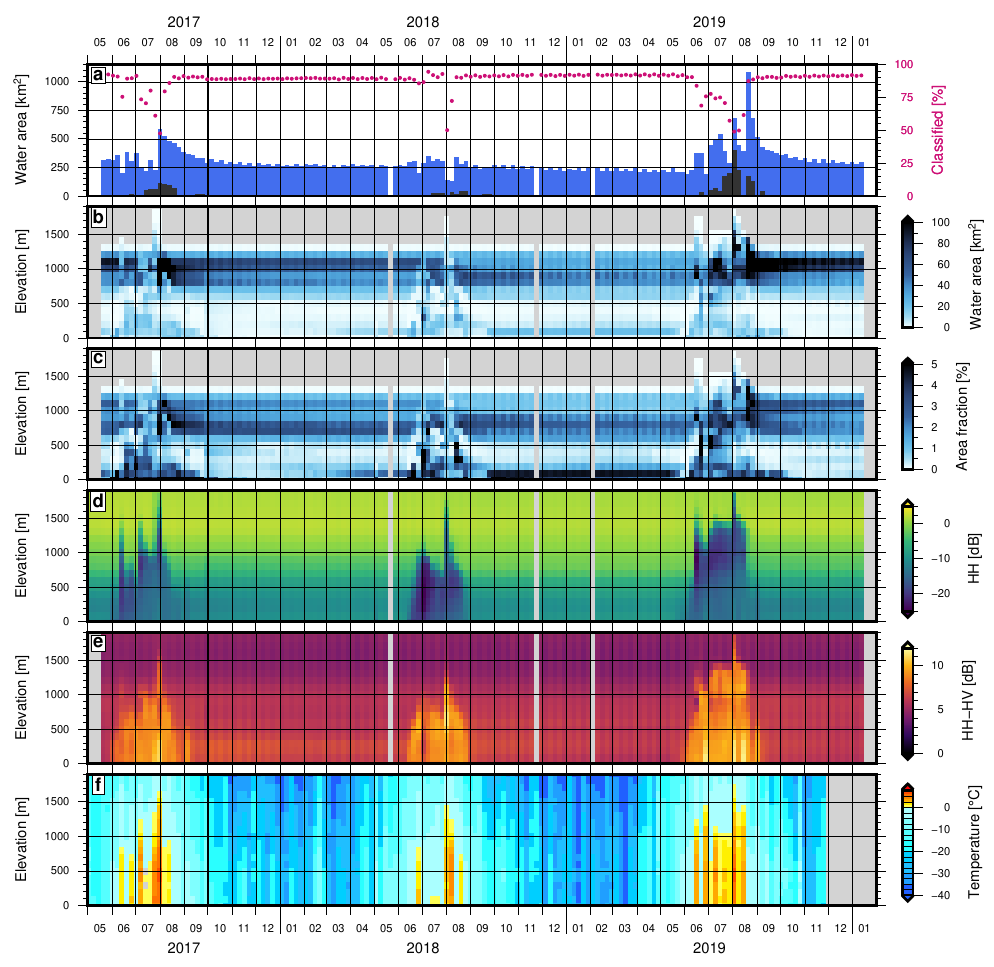
Figure 4. ( a ) Liquid water area classified on 79NG and ZI with PBC from S1 (SAR, blue) and from S2 (optical, black). The pink dots refer to the scale on the right and denote the fraction of the drainage basins area that was attributed unambiguously to any of the four classes. ( b ) Liquid water from S1 as in ( a ), binned at elevation steps of 100m. ( c ) Fraction of the area classified as water. ( d , e ) Median of HH and HH–HV, binned by elevation. ( f ) Temperature from ERA5, binned by elevation. Only a few weeks after each melt season, no water is visible in optical S2 data anymore, but the SAR data shows that the lakes are still there. Shallower lakes freeze through during the winter, as can be seen at the lower part of the region in Figure 3. When all the water in the lake is frozen, the dielectric contrast at the water/lake-ice-interface at the top of the water body vanishes. This causes a significant reduction in surface scattering, and hence, the HH–HV difference can no longer distinguish between the frozen lake water and the surrounding glacier ice. However, lakes with a water depth from several meters up to tens of meters (which is the case for many SGLs; see [17,27,40–42]) have a heat